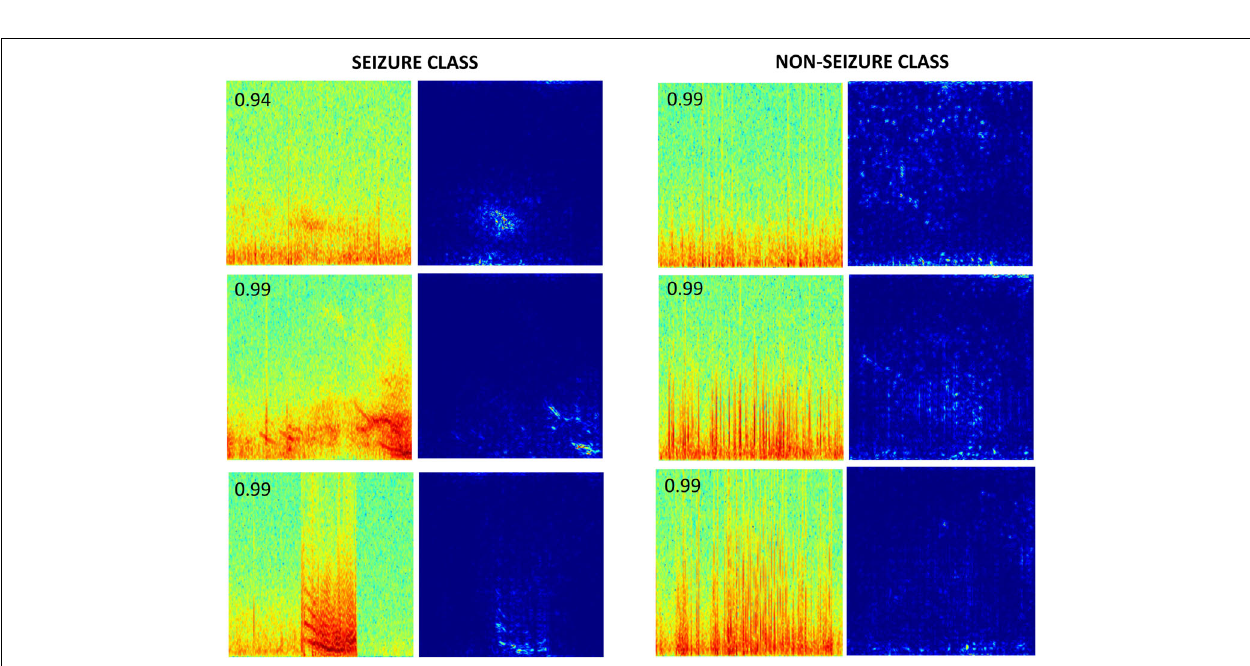
FIGURE 9 | Saliency maps of a few correctly classified seizure and non-seizure class ECoG channels by the ResNet50 ESC model. The number on the top left corner in each spectrogram image is the prediction probability of the model for the respective class.